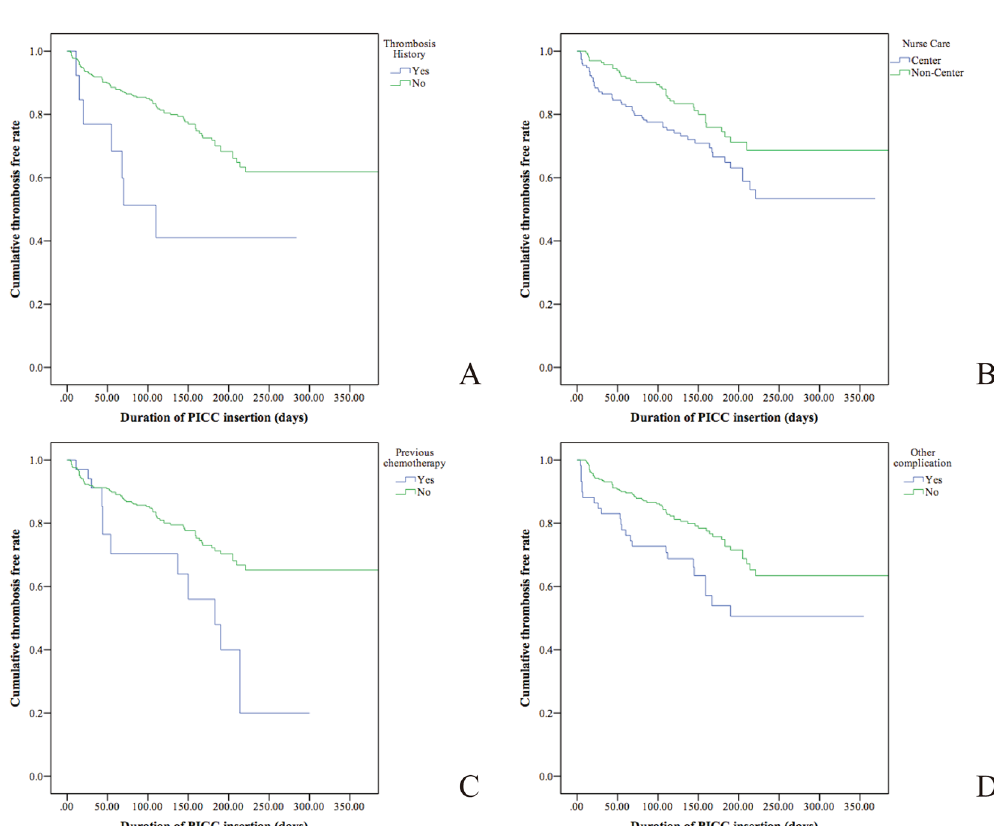
Figure 2. Cumulative thrombosis free rate of the duration of PICC insertion for the dichotomous variables. ( A ) Thrombosis history or not. ( B ) Center care or not. ( C) Previous chemotherapy or not. ( D ) Have other complications or